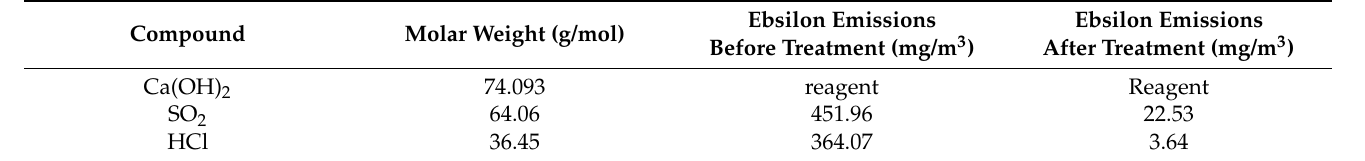
Table 12. Molar weights and emissions concentrations of sulfur oxides and hydrochloric